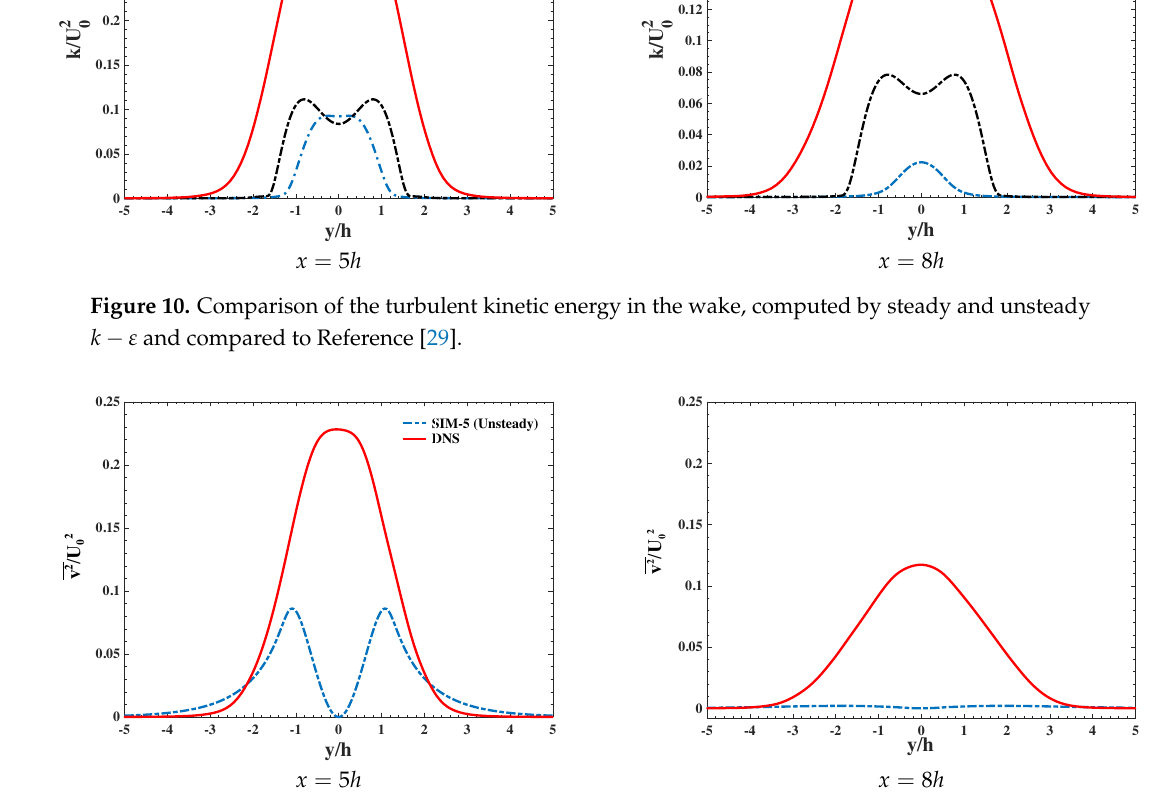
Figure 11. Comparison of Reynolds normal stress in the wake, computed by unsteady k − ε and compared to Reference [29].